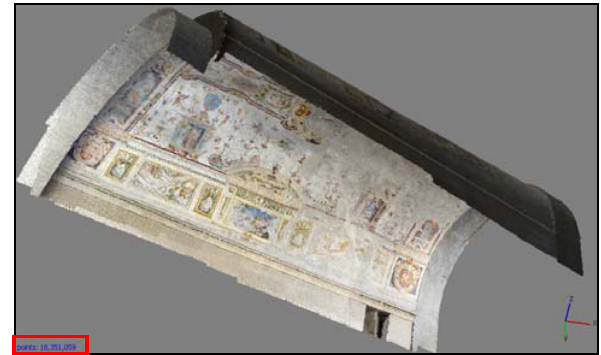
Figure 14 – Global Dense Point Cloud: more than 18M points give sharpness and definition enough to the photogrammetric project and at the same time, enough points to be compared with the ones got by scanning.